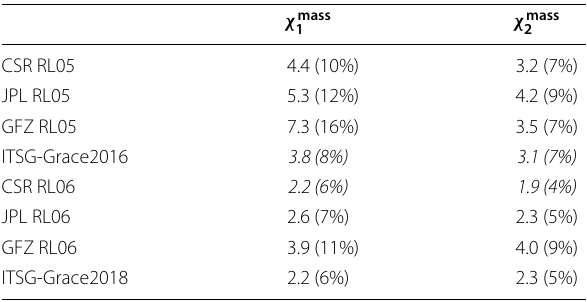
Table 2 Empirical standard deviations (mas) of the RL05 and RL06 GRACE-based equatorial effective angular momentum functions